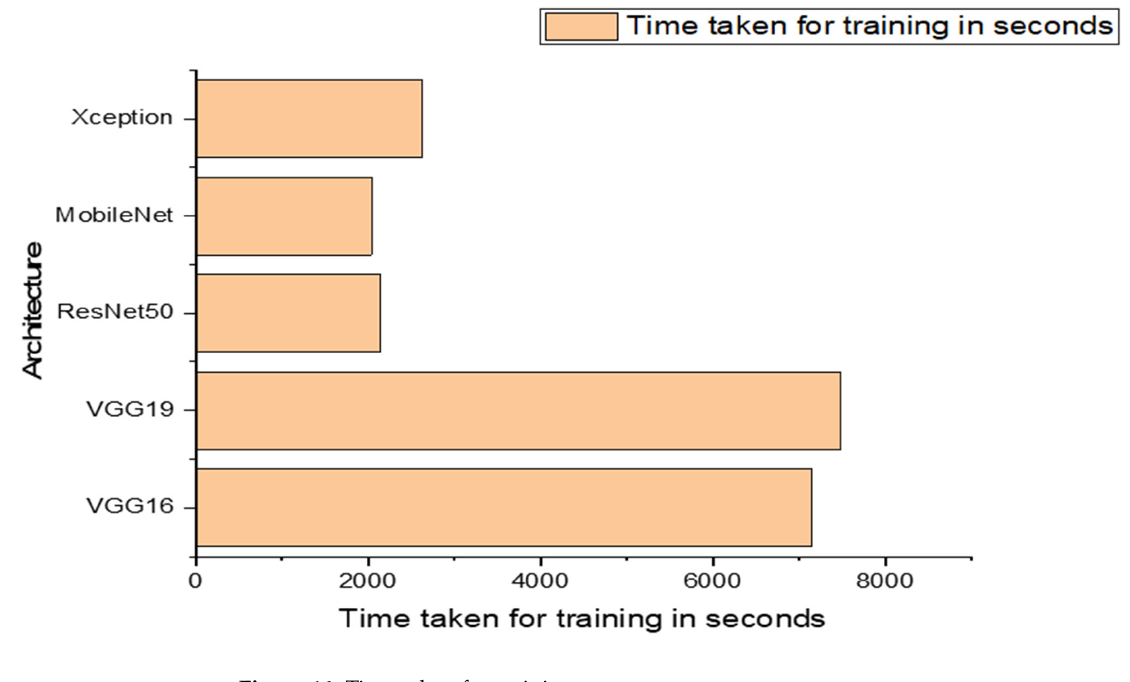
Figure 14. Time taken for training.